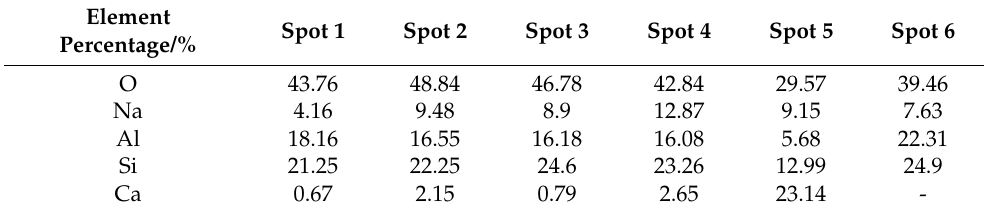
Figure 7. Microstructure of alkali-activated cement under different curing conditions: ( a ) FB-7 d; ( b ) FB-28 d; ( c ) FH80-24 h; ( d ) FZ80-24 h; ( e ) GZ80-24 h; ( f ) MZ80-24 h. Table 3. Elemental distributions of different alkali-activated